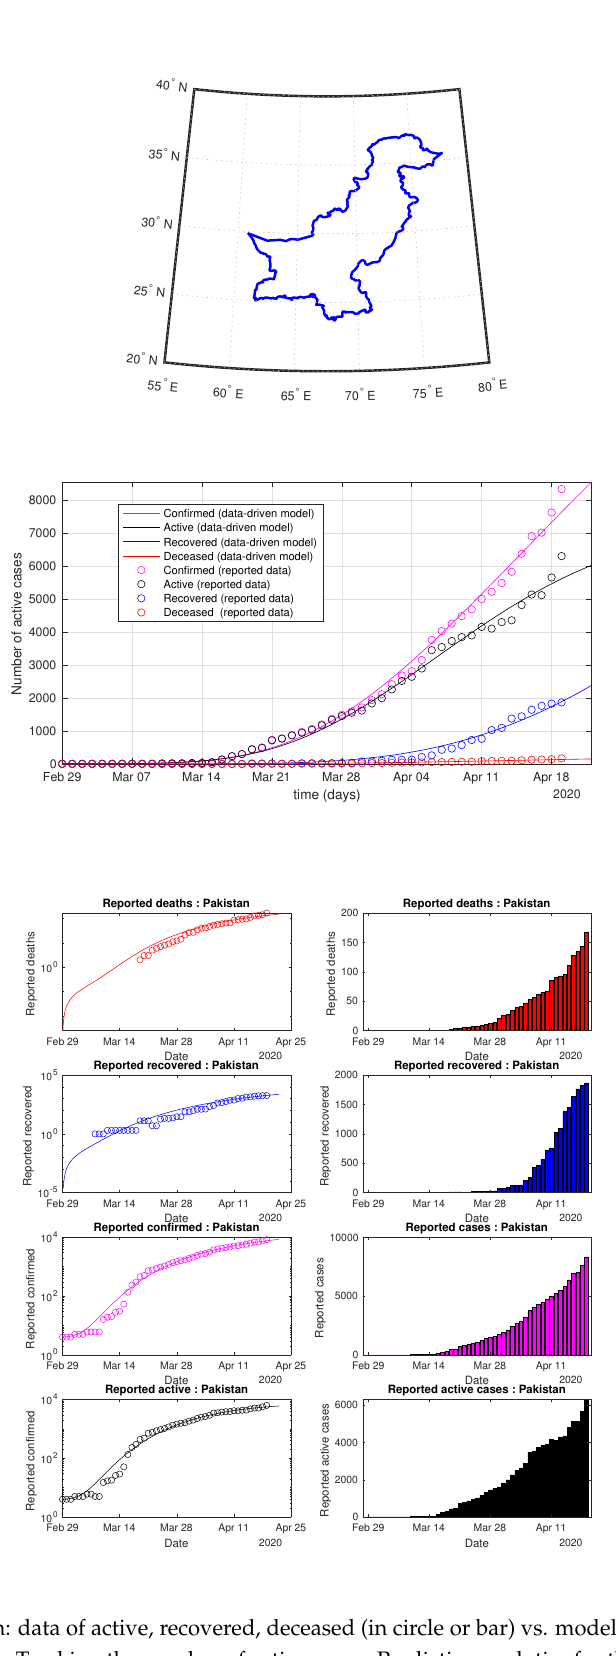
Figure 39. Pakistan: data of active, recovered, deceased (in circle or bar) vs. model of active, recovered, deceased over time. Tracking the number of active cases. Predictive analytics for the next couple